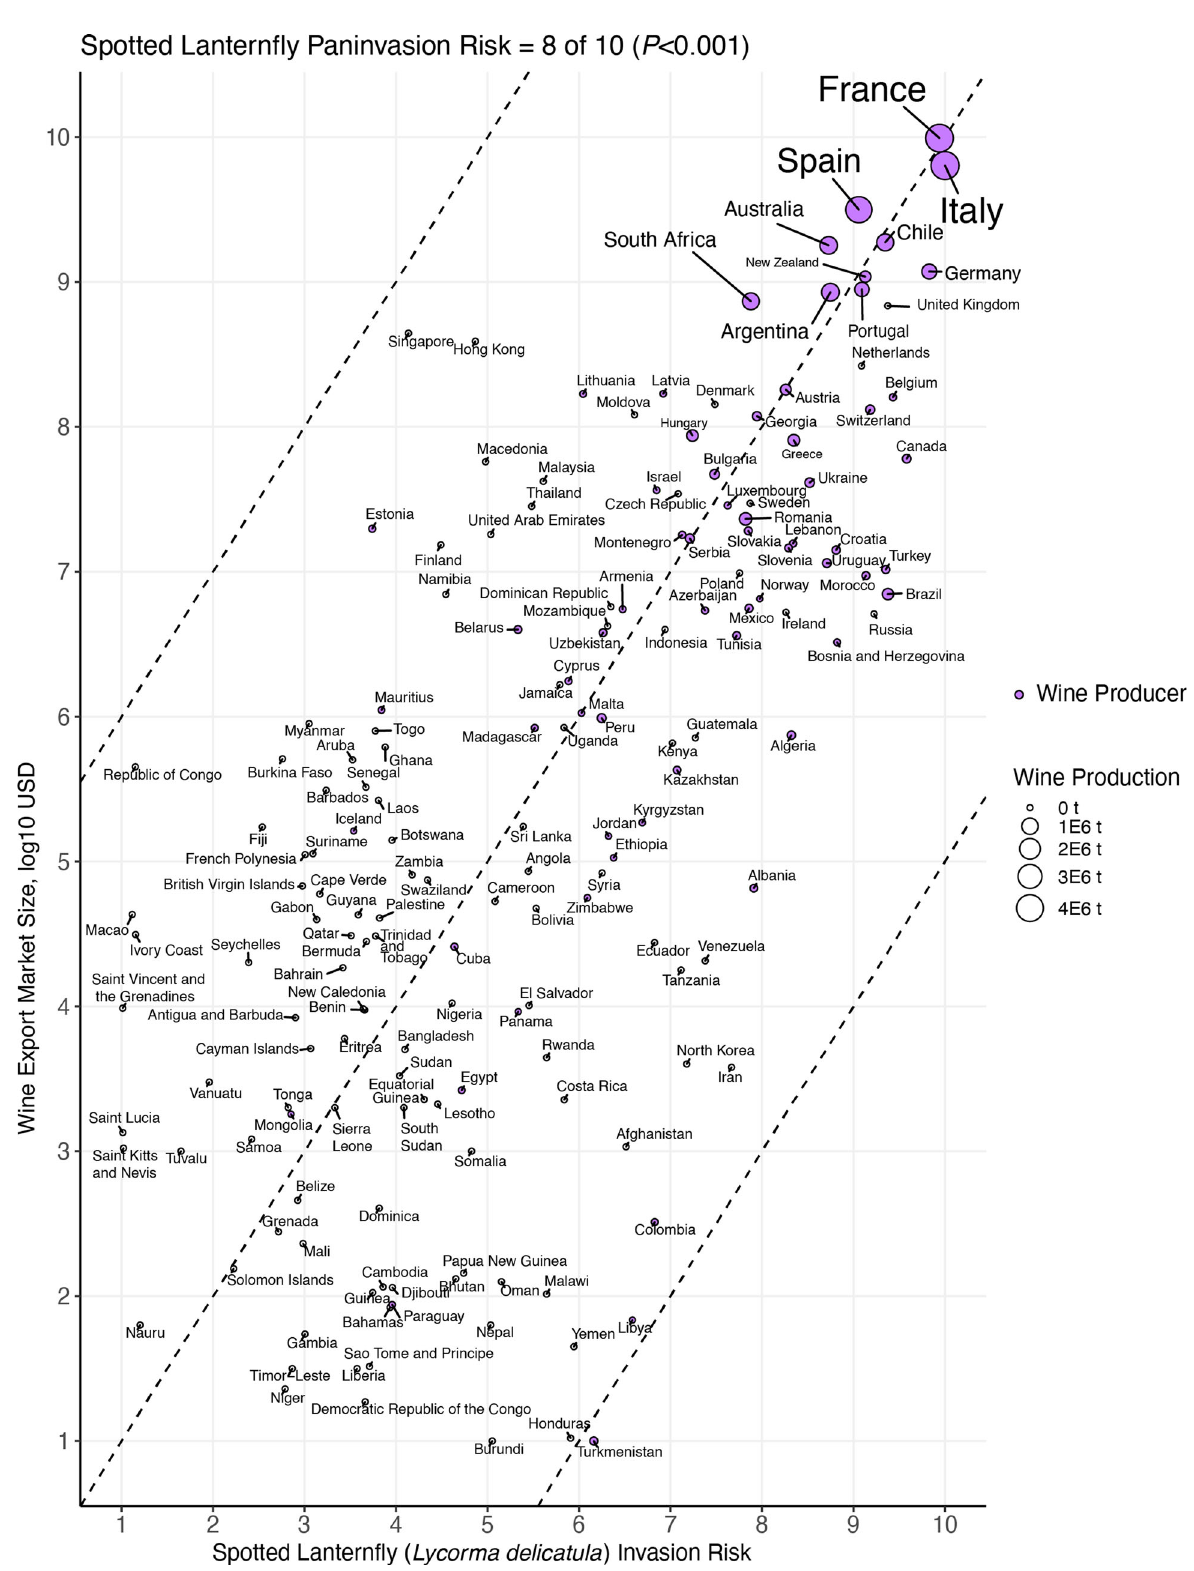
Fig. 6 Spotted lantern fl y ( Lycorma delicatula ) paninvasion risk is an 8 out of 10 due to the correlation between country wine export market size and invasion risk. Dashed lines are one-to-one guidelines at – 0.5, 0, 0.5 intercepts. Point color indicates high and low wine-producing regions. Point and label size depict wine production in metric